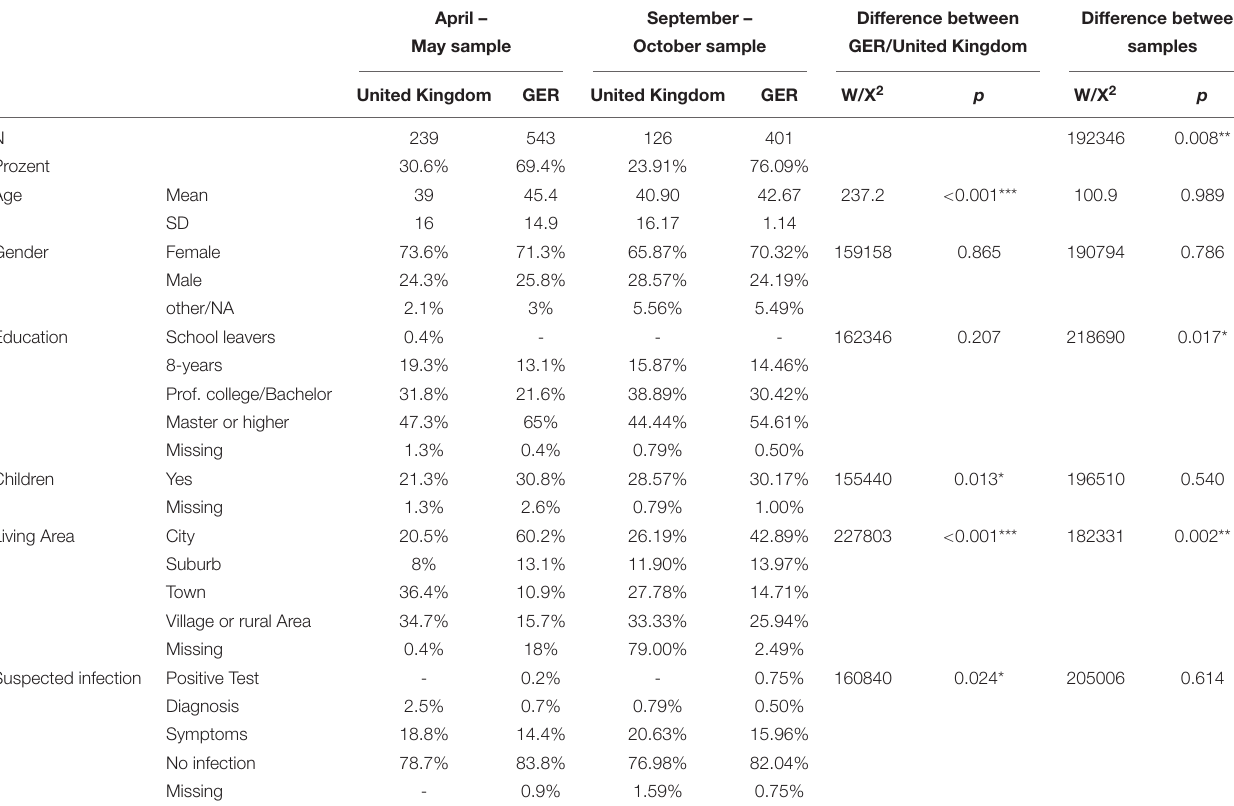
TABLE 1 | Demographics and suspected infection among the samples divides by country.